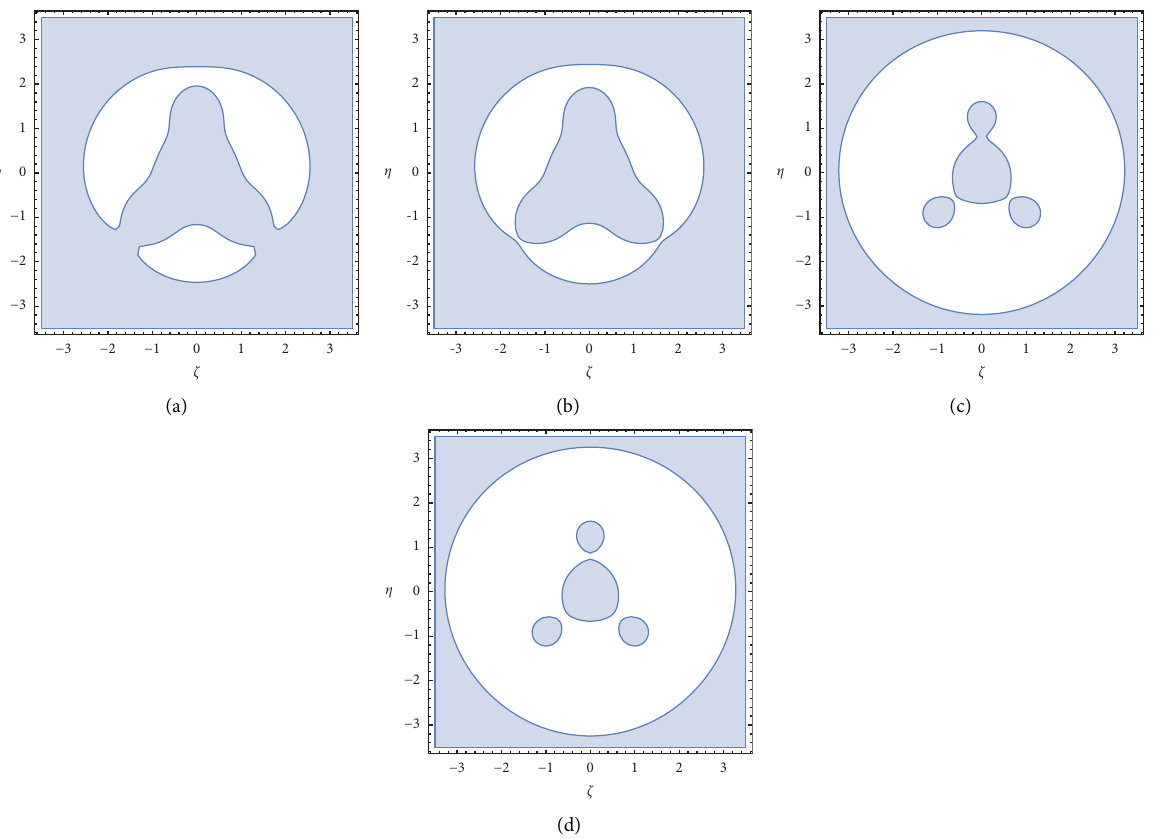
Figure 12: Case III: regions of motion for m